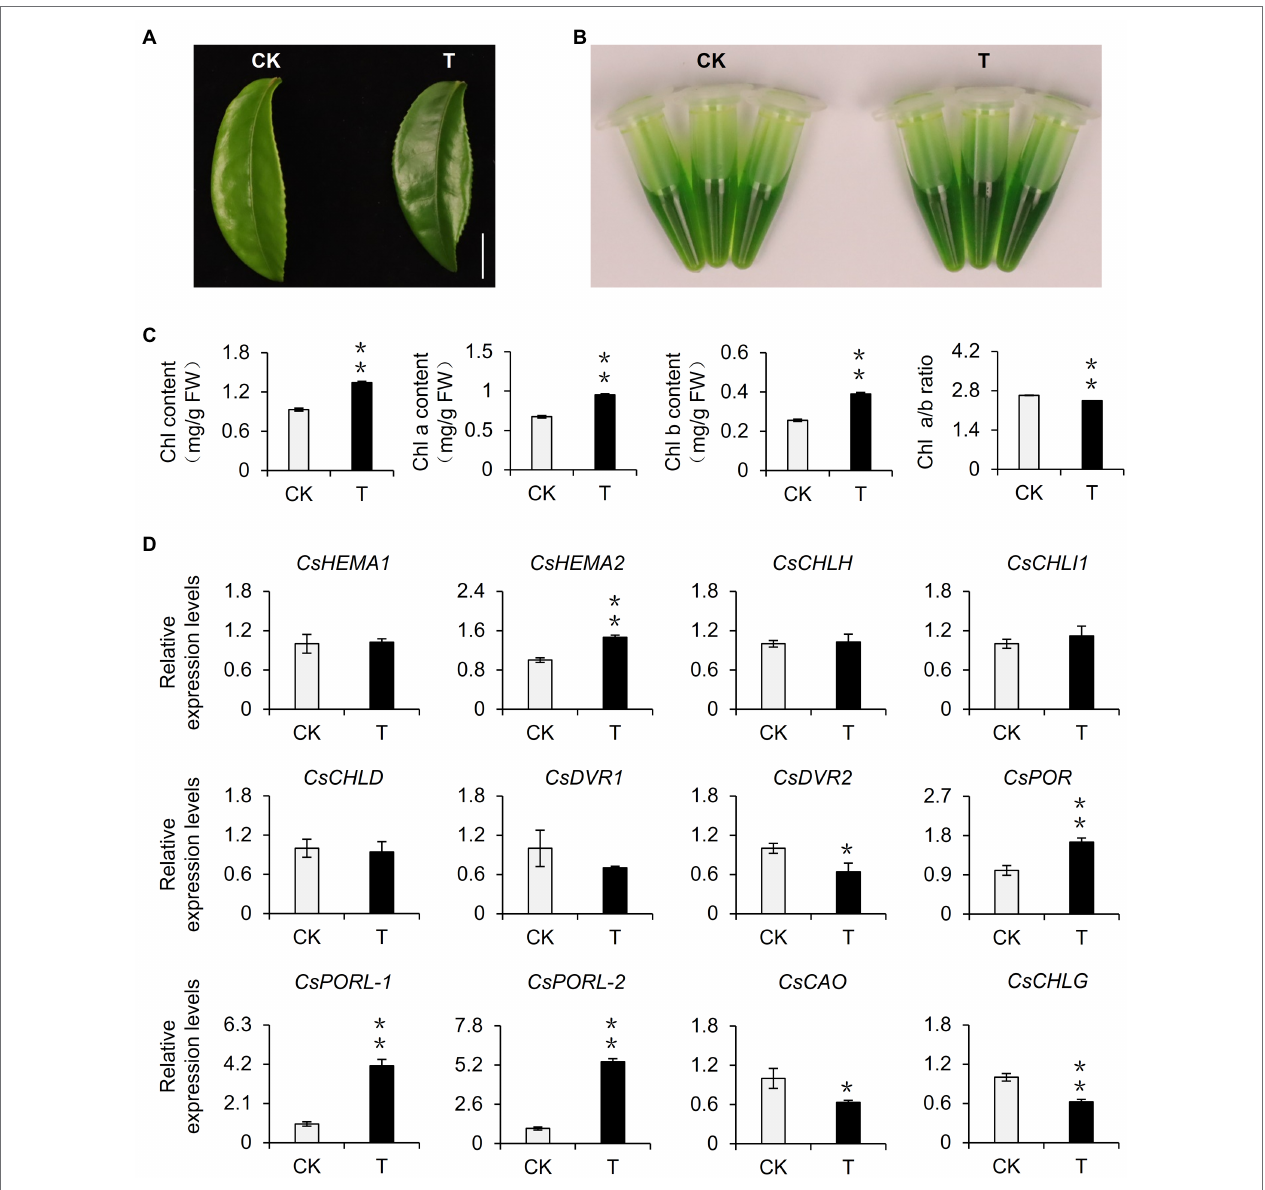
FIGURE 2 | Effect of reduced light intensity on the chlorophyll content of tea leaves and the expression of related genes. (A) The phenotype of third leaf after different light intensity treatments. Bar = 1 cm. (B) The comparison of leaf pigments after different light intensity treatments. (C) The change of chlorophyll content after different light intensity treatments. Chl: total chlorophyll; Chl a: chlorophyll a; Chl b: chlorophyll b; and FW: fresh weight. (D) The changes in the gene expression of chlorophyll synthesis pathway after different light intensity treatments. CK: 252 μ mol m − 2 s − 1 ; T: 16.8 μ mol m − 2 s − 1 . CsEF1- α was used as an internal reference to normalized the changes. Data are expressed as mean ± SD ( n = 3). Mean denoted by different sign indicates significant differences between the treatments in the same time (*mean p < 0.05; **mean p <